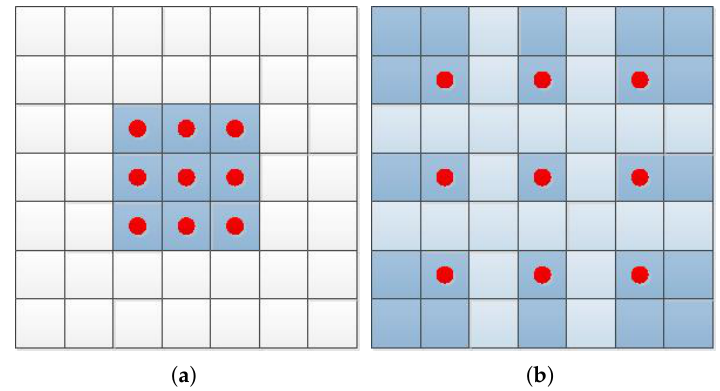
Figure 2. ( a ) Traditional convolution ( b ) dilated